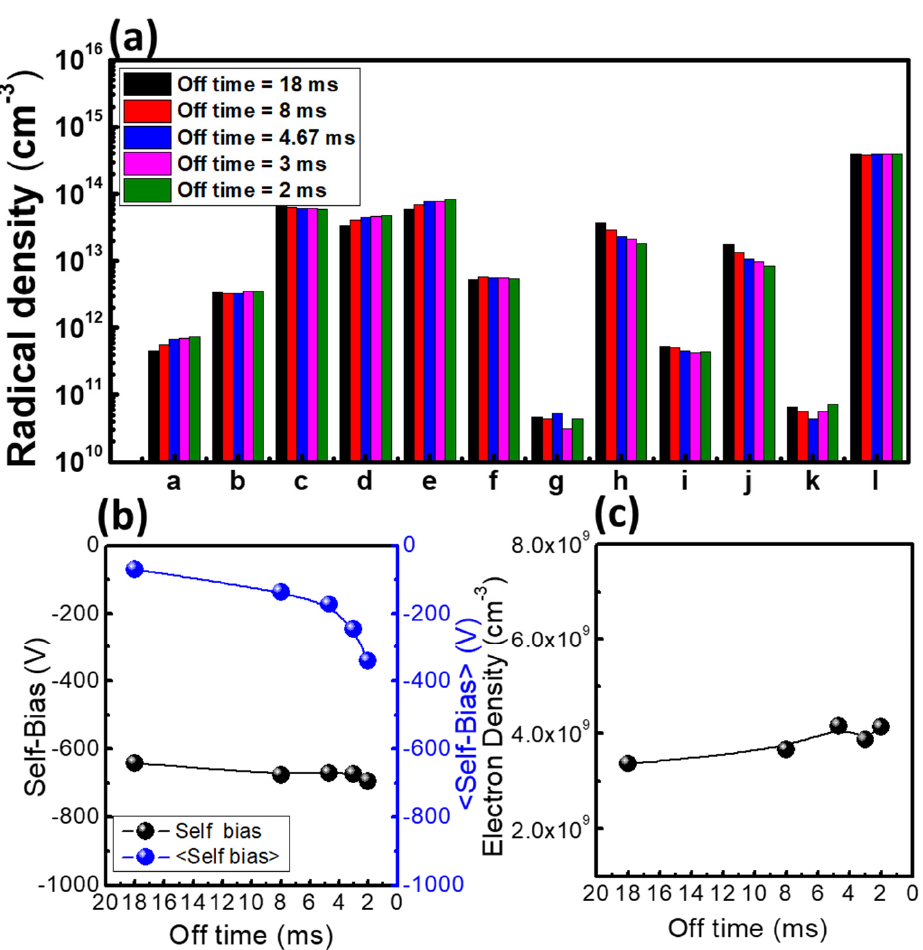
Figure 8. Diagnostic data as a function of off-time: ( a ) radical densities, ( b ) self-bias and averaged self-bias, and ( c ) electron density. The parameters for this experiment were a RF power of 400 W, a pressure of 20 mTorr, a C 4 F 8 /Ar gas ratio of 1:1, and a pulse on-time of 2 ms.